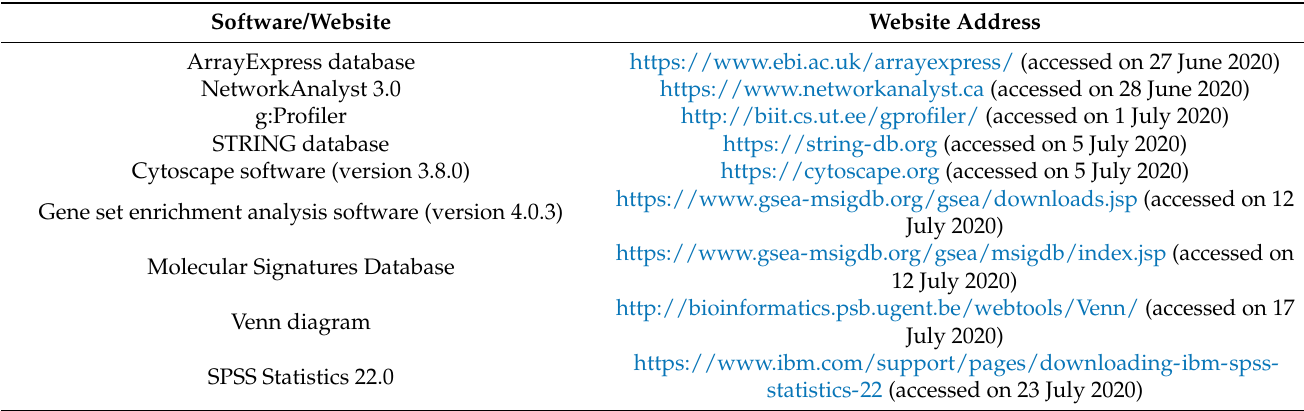
Table A3. Software and websites used in this